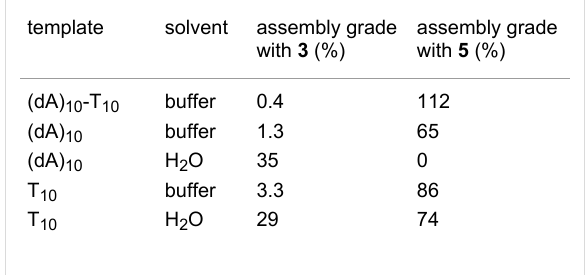
Table 3: Self-assembly ratios of 3 and 5 with single-stranded tem- plates (dA) 10 , T 10 and double strand (dA) 10 -T 10 under pure aqueous (no salts) and buffer conditions (50 mM NaP i , 250 mM NaCl, pH 7). The self-assembly ratio was determined by UV–vis absorption after centrifugation as described in the text and describes the number of assembled pyrene moieties with respect to the number of binding sites at the template, e.g., 10 for T 10